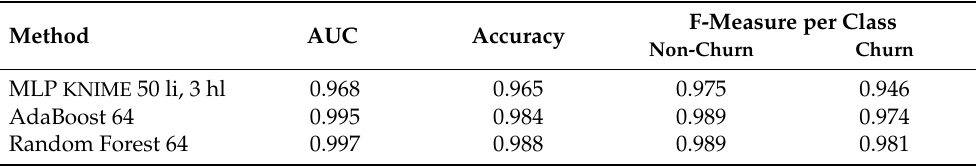
Table 4. Models’ performance on the testing set (training with all development data, training and